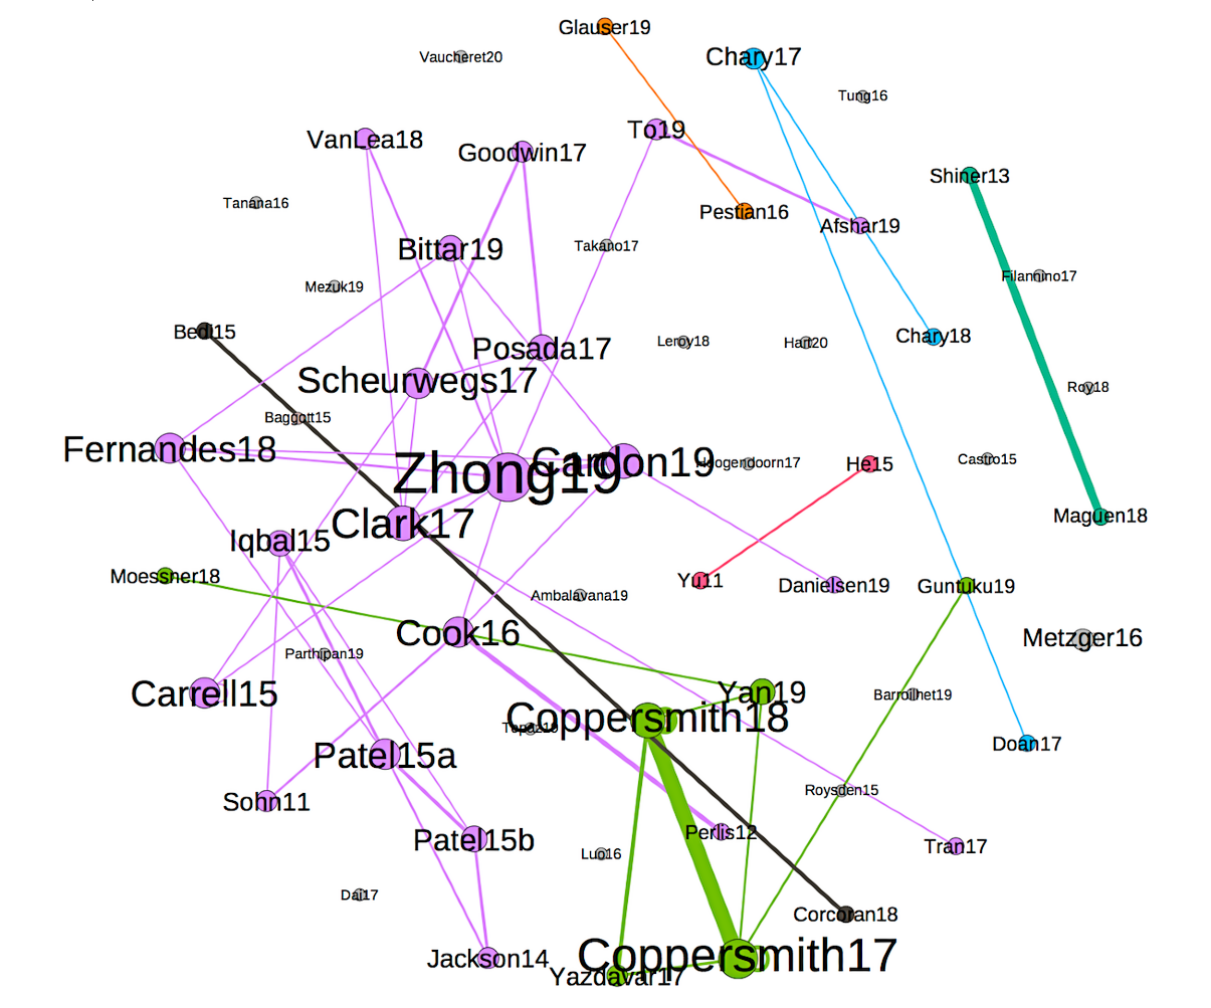
Figure 5. Graph of